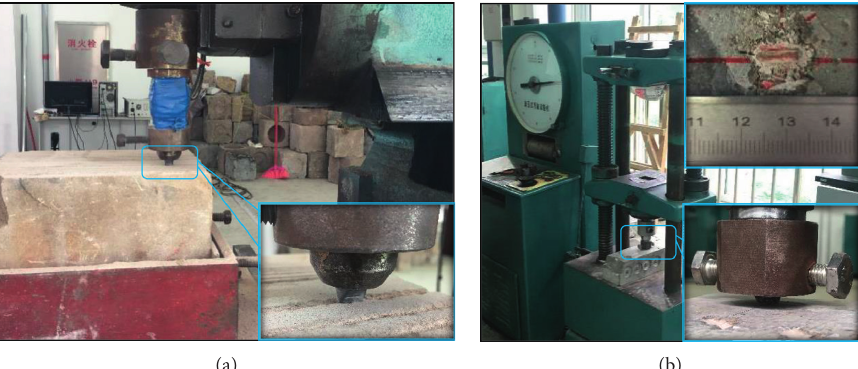
Figure 2: Φ 14mm wedge tooth cutting unit load measurement experiment. (a) Single tooth scraping and cutting experiment. (b) Single tooth invasion experiment.